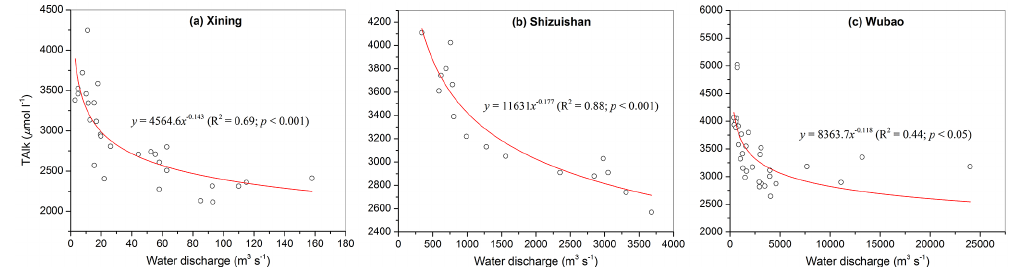
Figure 7. Dependence of TAlk on natural water discharge for different water discharge scales at typical sampling sites: (a) is from a tributary and (b) and (c) are from the Yellow River mainstem (see Fig. 1 for locations).